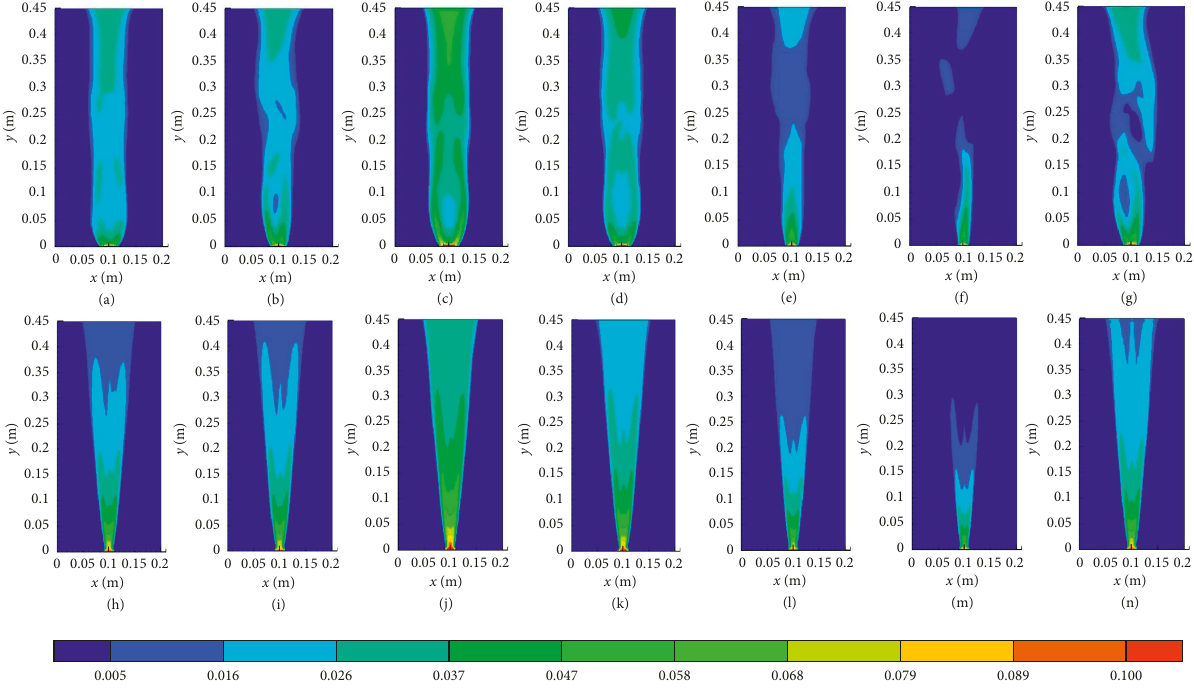
Figure 5: Time-averaged gas holdup distribution. (a) Case 1, (b) Case 2, (c) Case 3, (d) Case 4, (e) Case 5, (f) Case 6, (g) Case 7, (h) Case 8, (i) Case 9, (j) Case 10, (k) Case 11, (l) Case 12, (m) Case 13, and (n) Case 14.